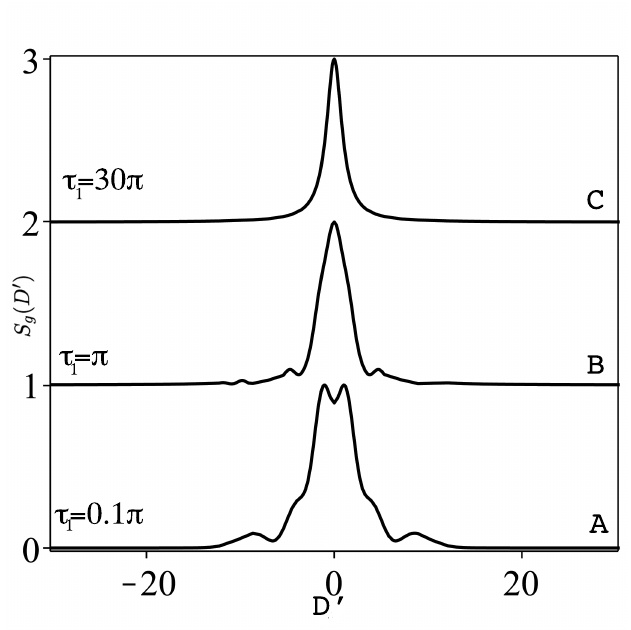
Figure 7. As Figure 6 for n = 1 pulse but with strong field Ω 1 = 10.